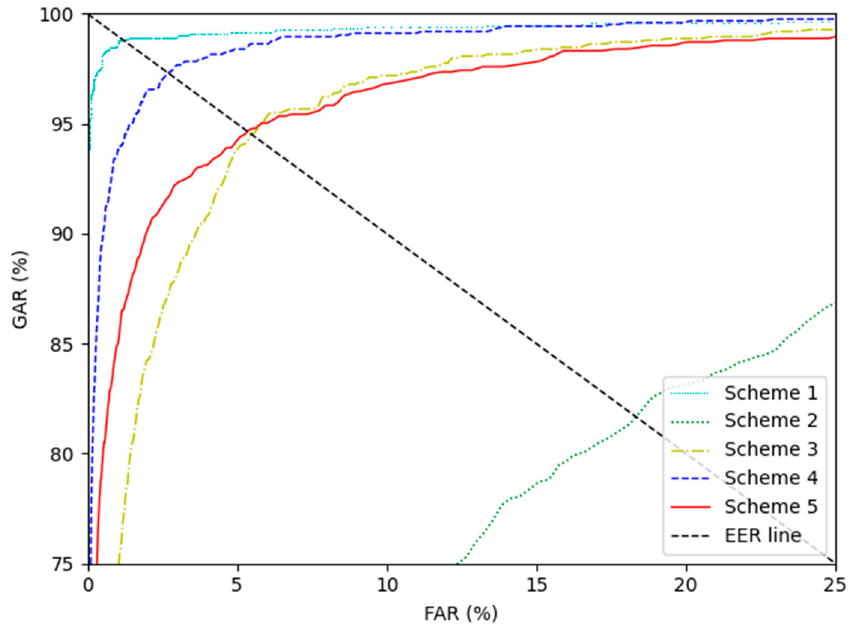
Figure 27. ROC curves of finger-vein recognition for schemes 1–5 with PolyU-DB (random motion blur and optical blur with intensity 11 × 11 (Gaussian filter size) and 11 (Gaussian filter standard deviation)).